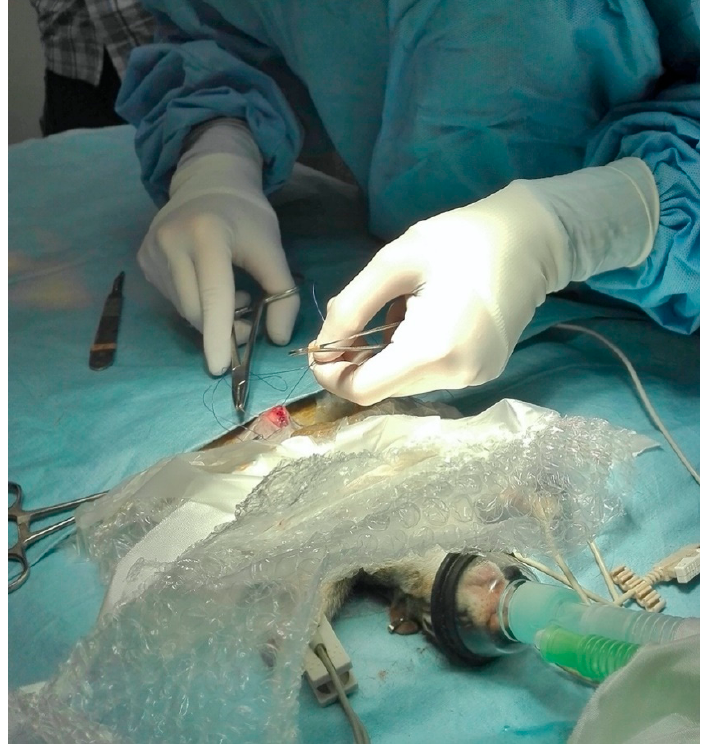
Figure 5. Surgical wound closure in a gray squirrel undergoing gonadectomy.